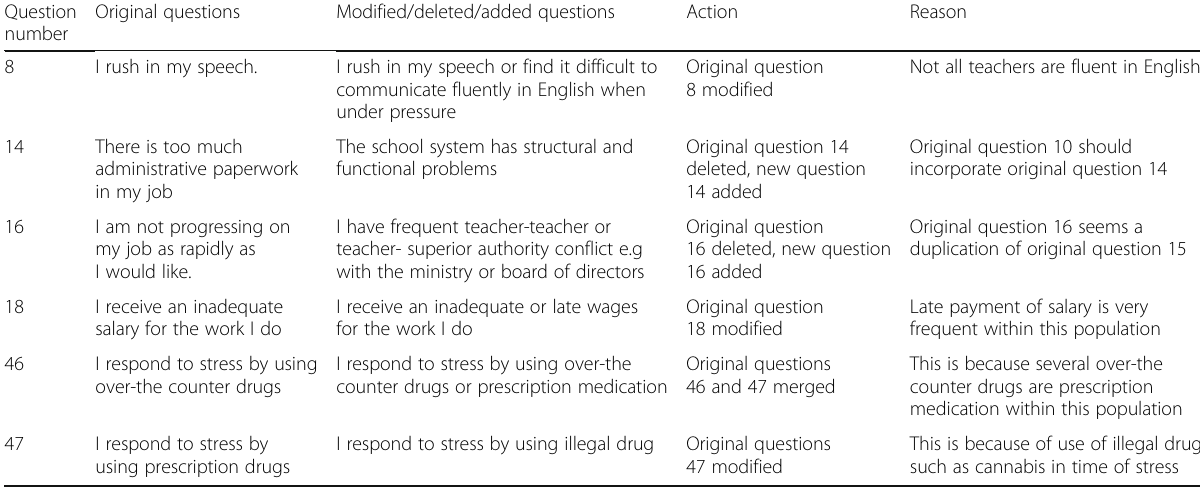
Table 1 Modifications of the original TSI made by the final expert panel Question